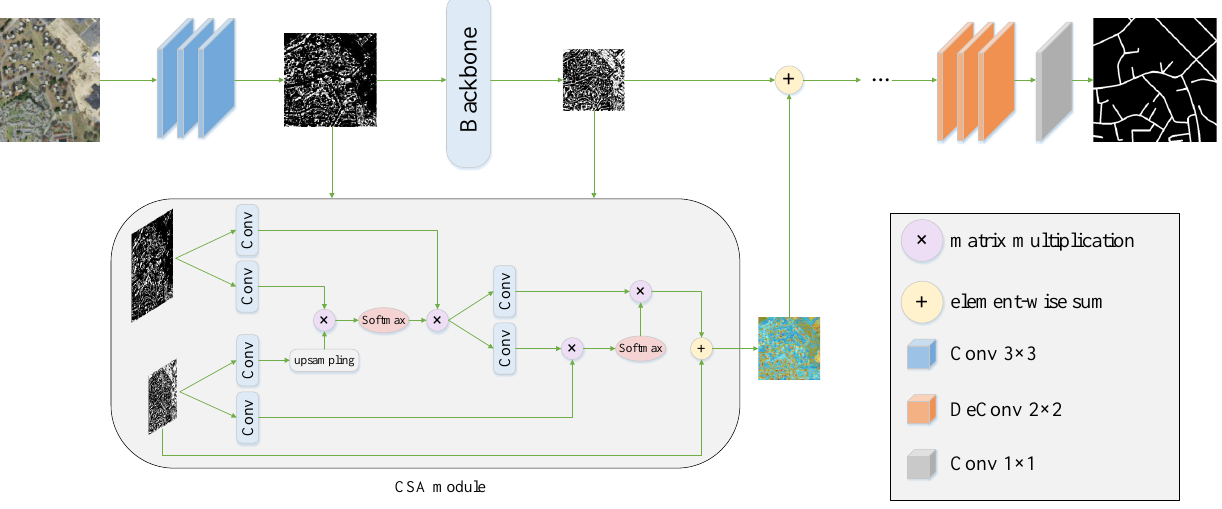
Figure 2. The overall structure of the proposed